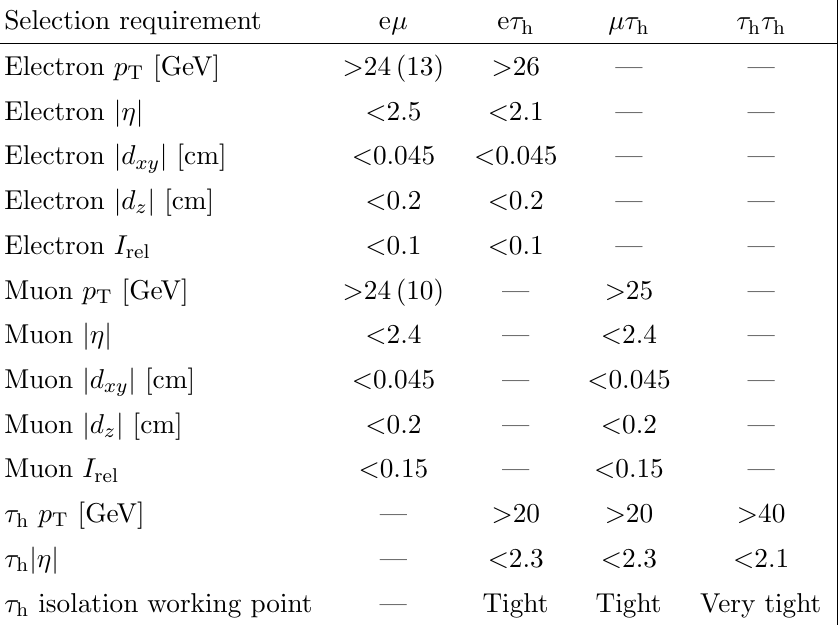
Table 1. Summary of lepton selection requirements for the analysis. Entries with a second value in parentheses refer to the lepton with the higher (lower) p T .